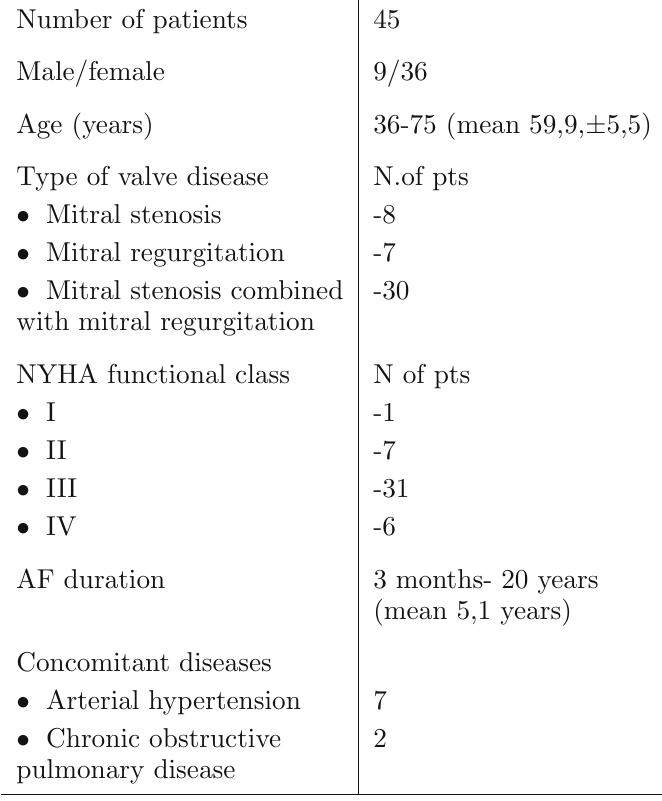
Table 1 Preoperative patients’